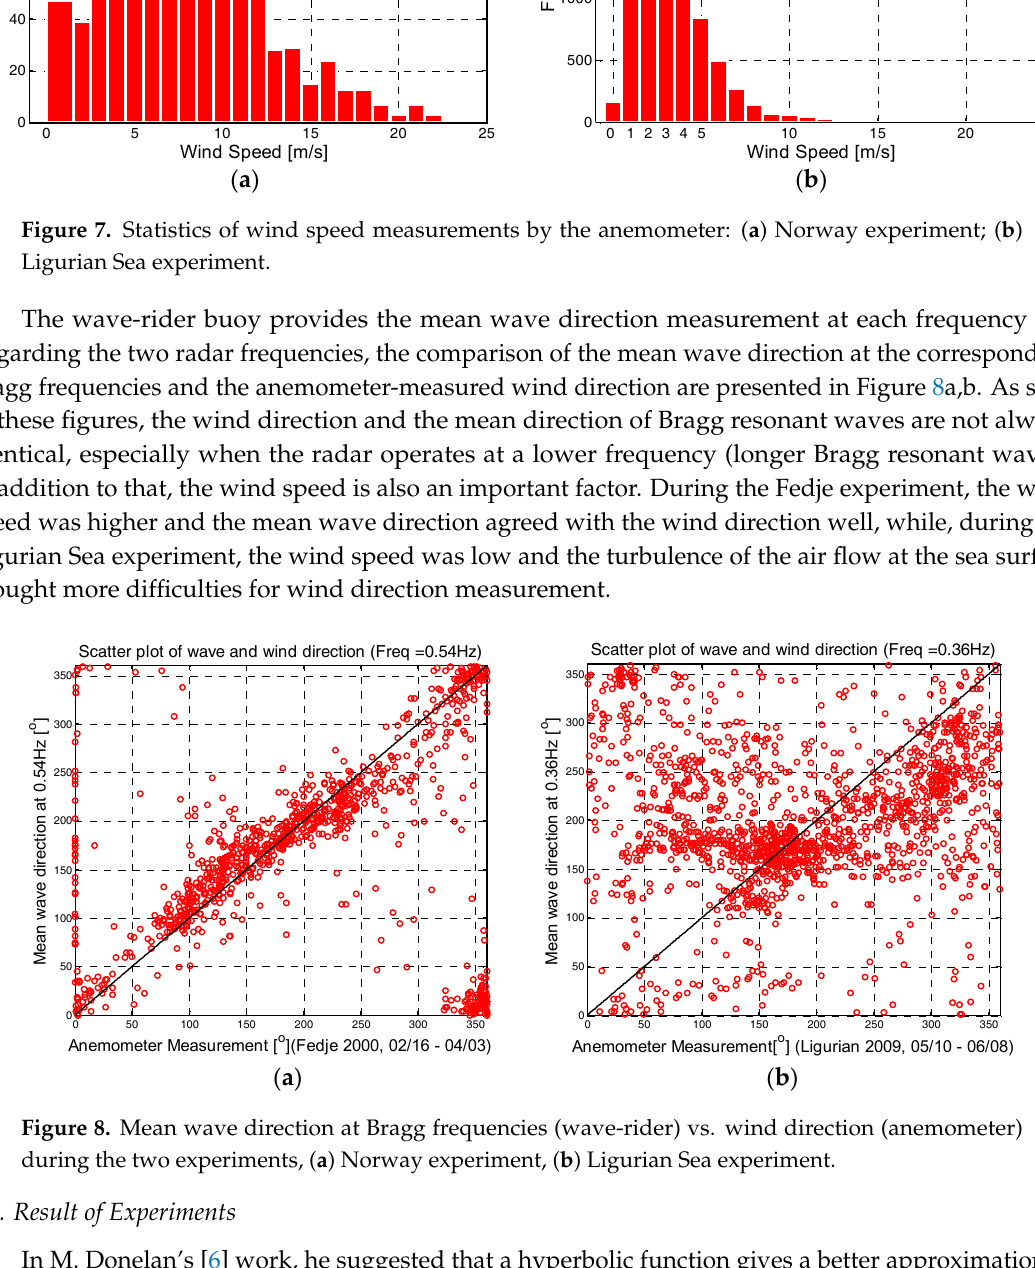
the two experiments, (a) Norway experiment, (b) Ligurian Sea experiment.